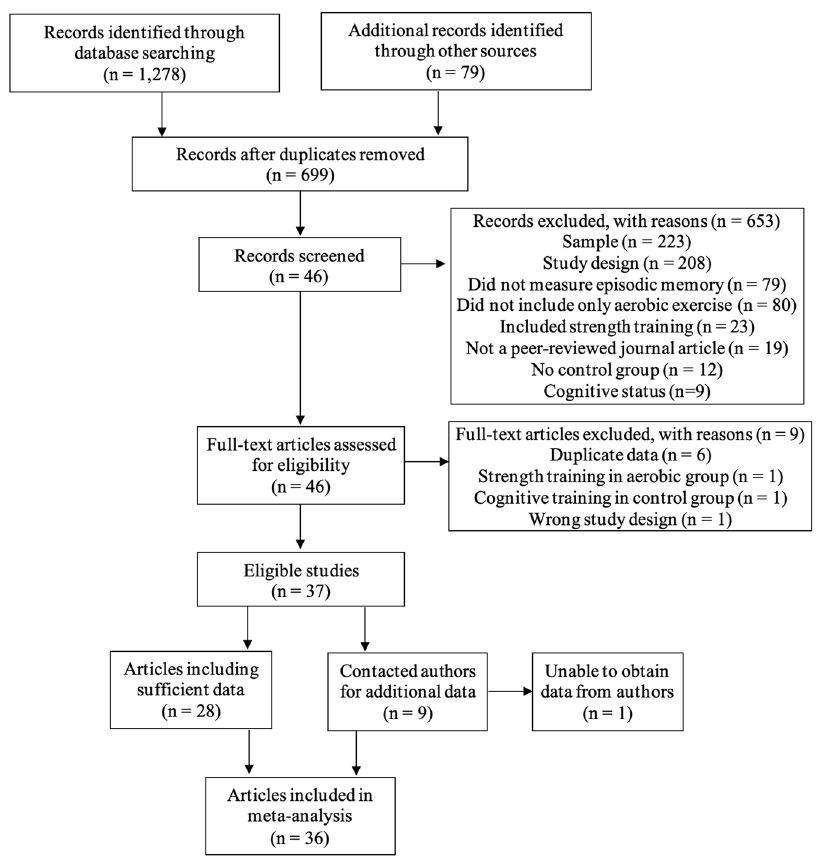
Fig. 1 Prisma fl ow diagram. Adapted from: Moher D, Liberati A, Tetzlaff J, Altman DG, The PRISMA Group (2009). Preferred Reporting Items for Systematic Reviews and Meta-Analyses: The PRISMA Statement. PLoS Med 6(7): e1000097.